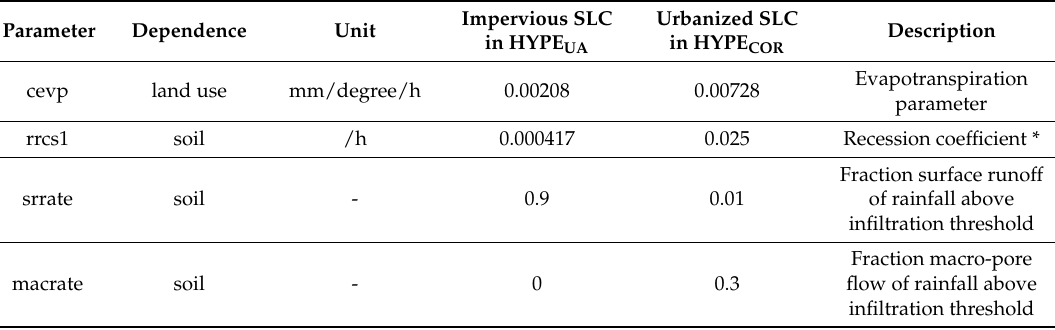
Table 2. HYPE parameters that were adjusted in the impervious land use characteristic (impervious SLC). New parameters for impervious SLC (HYPE UA ) and existing parameters for urbanized SLC(HYPE COR ) are shown for comparison. * Parameters for the uppermost soil